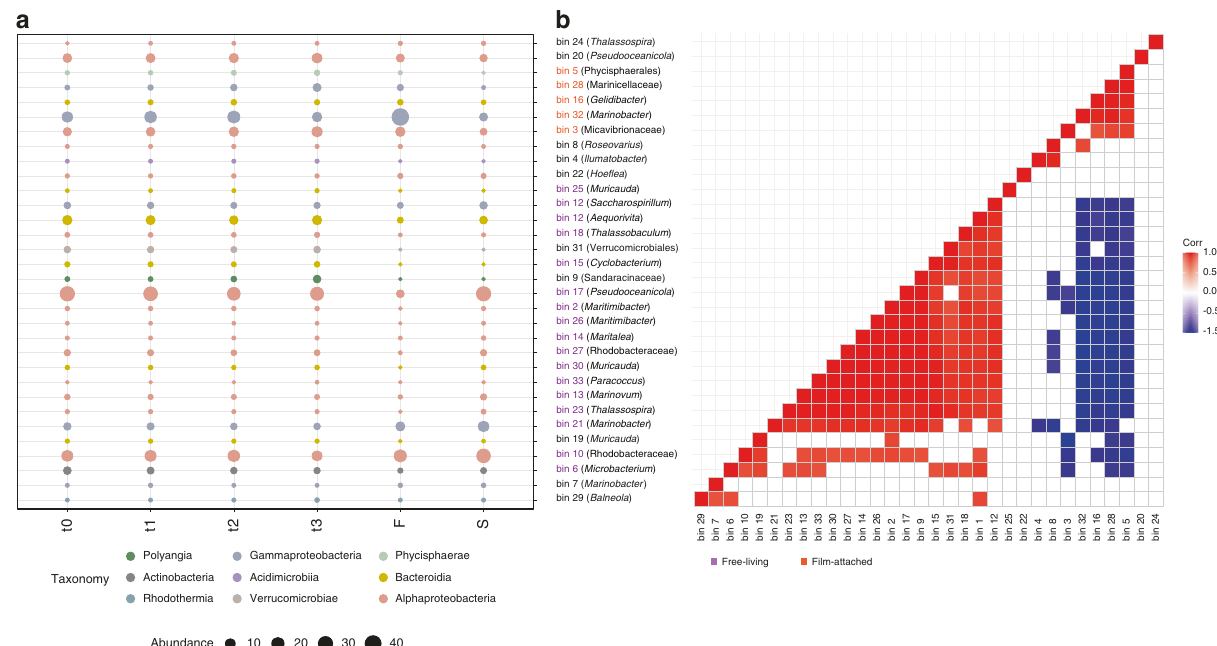
Fig. 3 Bins pro fi ling. Abundances were calculated by counting the mapped reads per bin. Percent abundances were calculated based on the number of mapped reads per metagenome. The percentage of unbinned reads per replicate metagenome can be found in Table S3. a Taxonomic abundance pro fi le during time series (t0, t1, t2, t3) in the presence of PF, fi lm-attached (F) and free-living cells (S) is shown. The size of the bubbles represent the average relative abundance of each bin in the I1 population. The color of each bubble represents a taxa. The bins belonging to the free-living and fi lm-attached bacteria fractions are highlighted in purple and red, respectively. The percentages for monomer cultures are averages of biological duplicates and the rest are the average of biological triplicates. b Correlation between the percent abundances of fi lm-attached and free-living bacteria. Negative correlations are shown in shades of blue, positive correlations are shown in shades of red. Percent abundance data for each biological replicate was used as input. Source data are provided as a Source Data fi